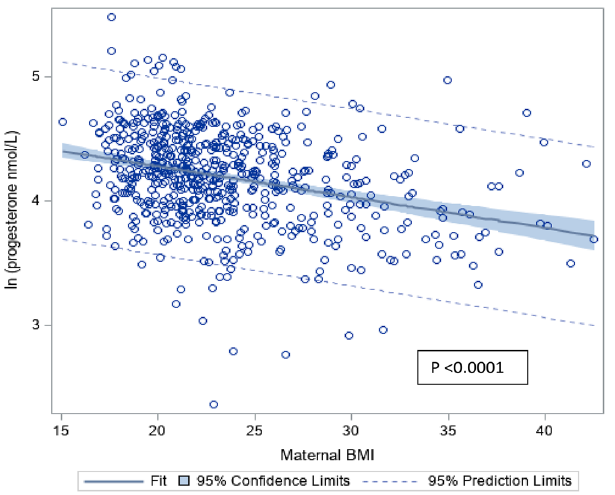
Figure 3. Relationship between maternal BMI and log serum progesterone levels, adjusted for maternal age, parity and gestational